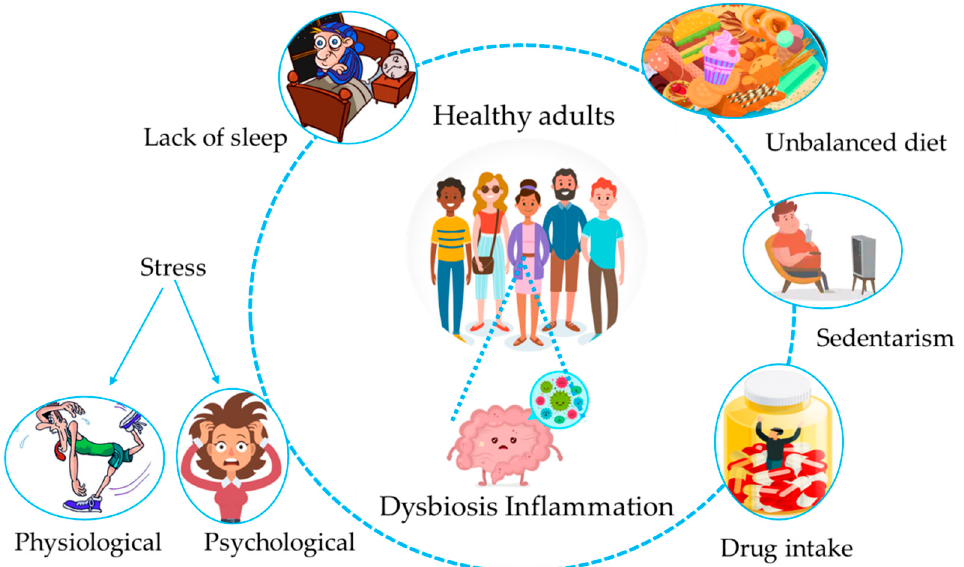
Figure 1. Interplay between lifestyle habits and the gut microbiota. A poor lifestyle characterized by an unbalanced diet, sedentarism, chronic intake of drugs, a lack of sleep, and physiological or psychological stress can lead to asymptomatic dysbiosis, and thus to inflammatory states, all contributing to disease development in the long term.